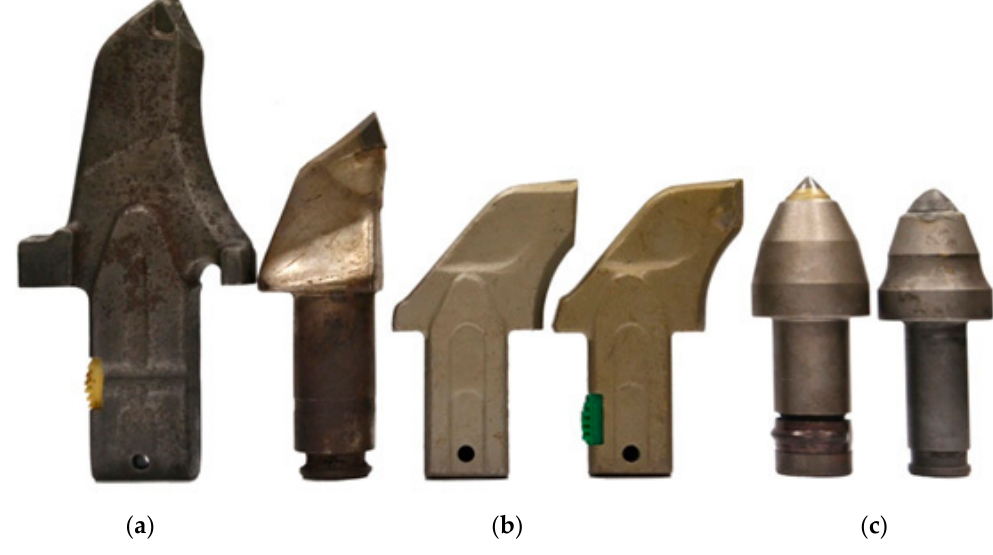
Figure 2. Cutting picks: ( a ) tangent; ( b ) radial; ( c ) conical.